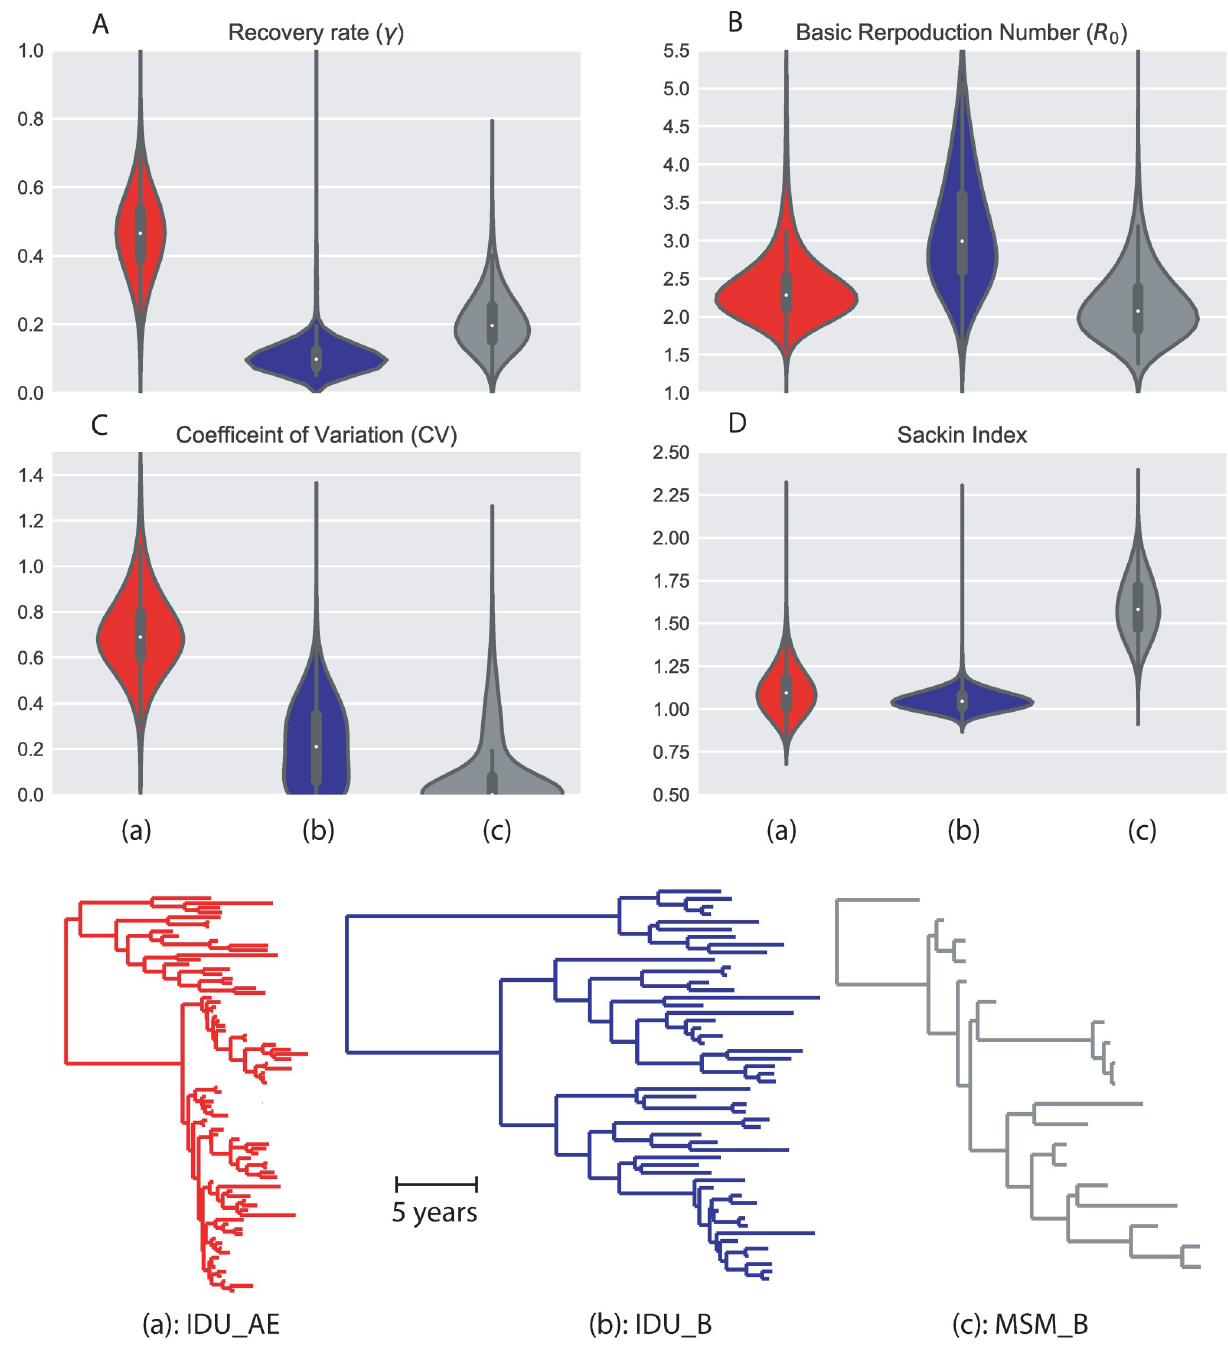
Fig 7. Estimation of heterogeneity and other epidemiological parameters for three HIV outbreaks in Sweden: IDU_AE (red), IDU_B(blue) and MSM_B (grey). On the top four panels, the distributions of the estimated parameters from a sample of 10000 posterior genealogies of each dataset are presented: the rate of diagnosis (A), the basic reproduction number (B), the Coefficient of Variation (C) and the Sackin Index normalized with the ‘PDA’ method (D). On the bottom, the time-scaled genealogies with the highest posterior probability are presented.